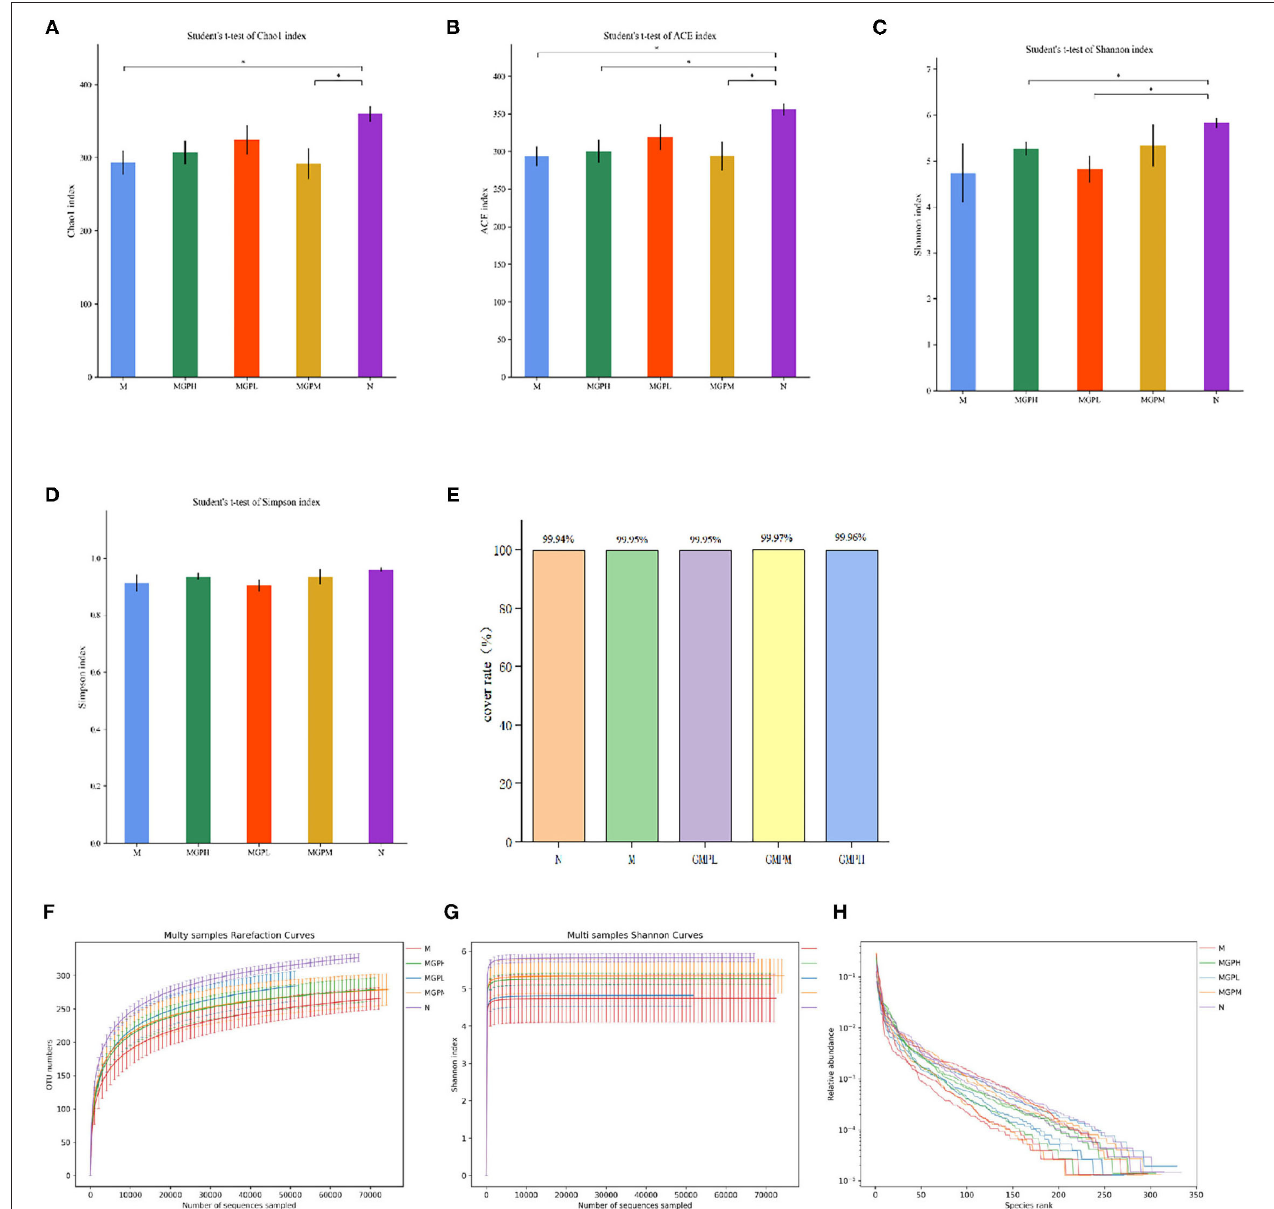
FIGURE 7 | Changes of intestinal flora in mice α diversity index. (A) Chao index. (B) Ace index. (C) Shannon index. (D) Simpson index. (E) Cover rate. (F) Rarefaction Curve. (G) Shannon index. (H) Rank Abundance Curve. Significance of difference: *means p < 0.05, **means p < 0.001, compared with group M. ## means p < 0.001, compared with group